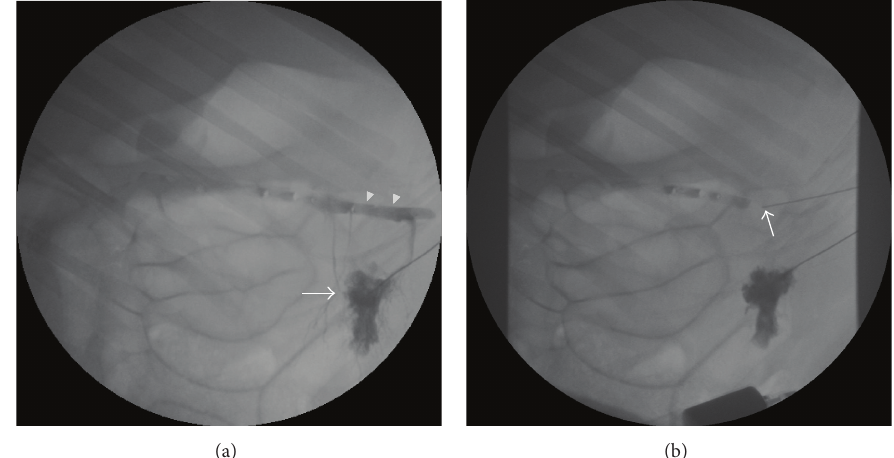
Figure 3: Transsplenic splenoportal venous sampling technique. (a) Digital fluoroscopic image demonstrating parenchymal blush with reflux of contrast through the splenic parenchyma opacifying the splenic vein (white arrowheads). (b) Digital fluoroscopic image demonstrating the passage of the second needle targeting the splenic